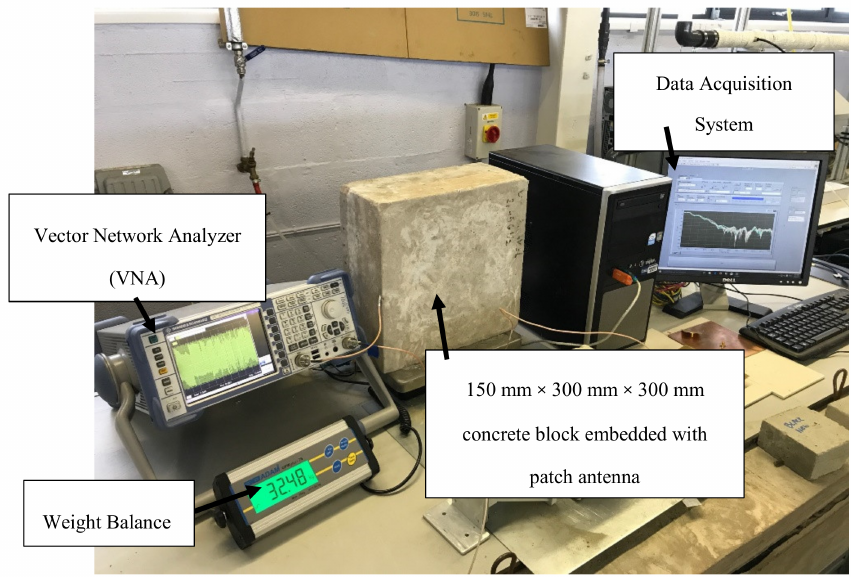
Figure 5. Experimental Setup for moisture content detection in concrete